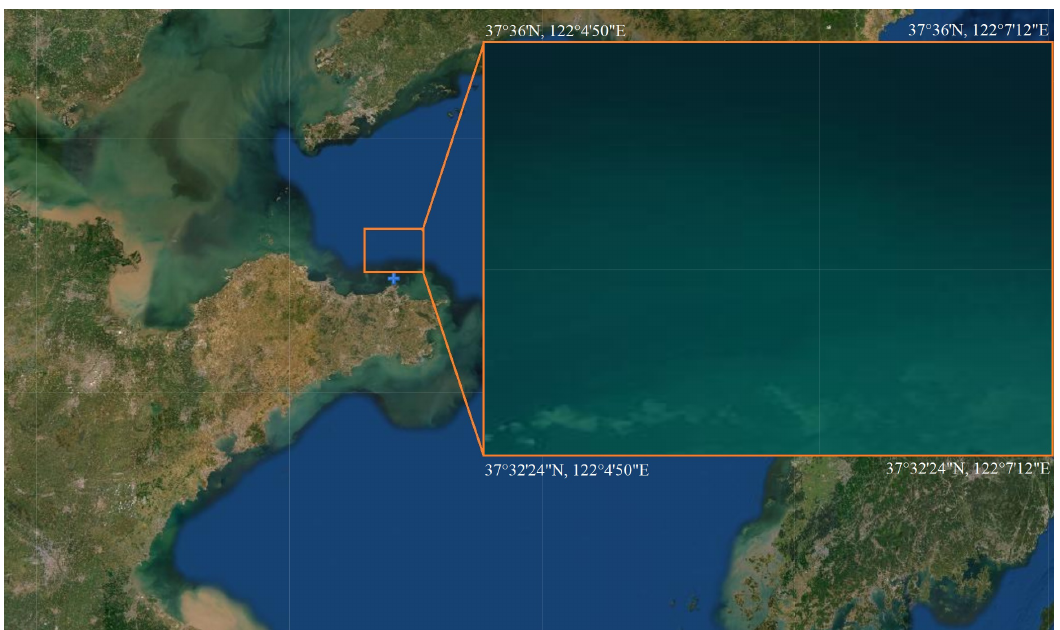
Figure 1. The area of data collection is situated in the northern part of Weihai City, Shandong Province, China. The area is approximately 20 square kilometers. In this area, a total of three types of sediment were collected, namely rock, sand, and mud.